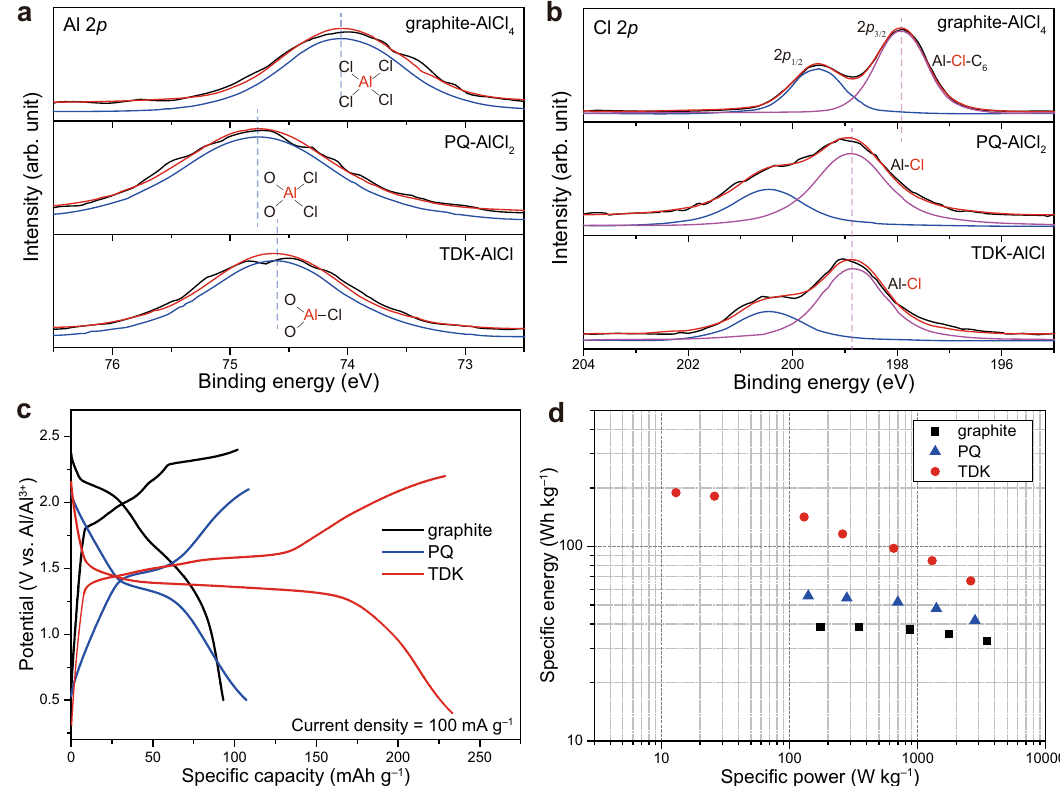
Fig. 5 Comparison of cathode materials exploiting AlCl 4 − , AlCl 2 + and AlCl 2 + ions. a , b XPS curves of graphite-AlCl 4 , PQ-AlCl 2 and TDK-AlCl; a Al 2 p and b Cl 2 p branches. c Galvanostatic voltage pro fi les of graphite, PQ and TDK when the current density is 100 mA g − 1 . d Ragone plots of cells based on graphite, PQ and TDK. The required amount of electrolyte was taken into account for this